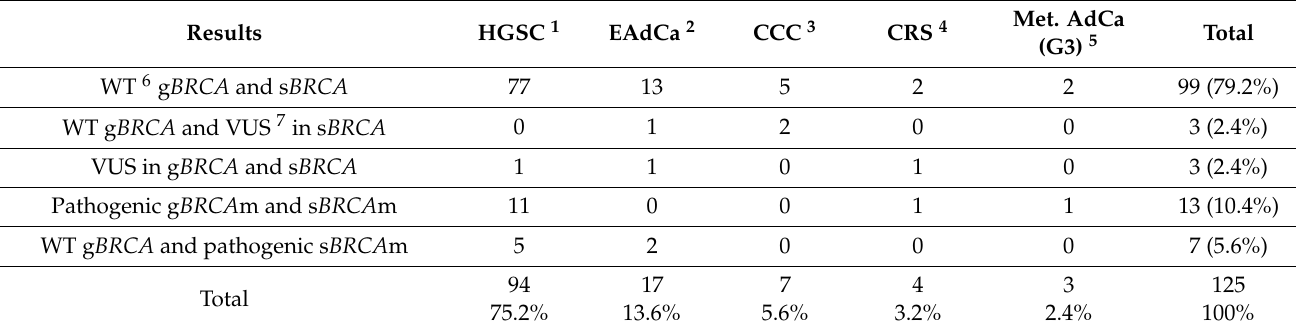
Table 1. The distribution of results between different tumour subtypes from BRCA1/2